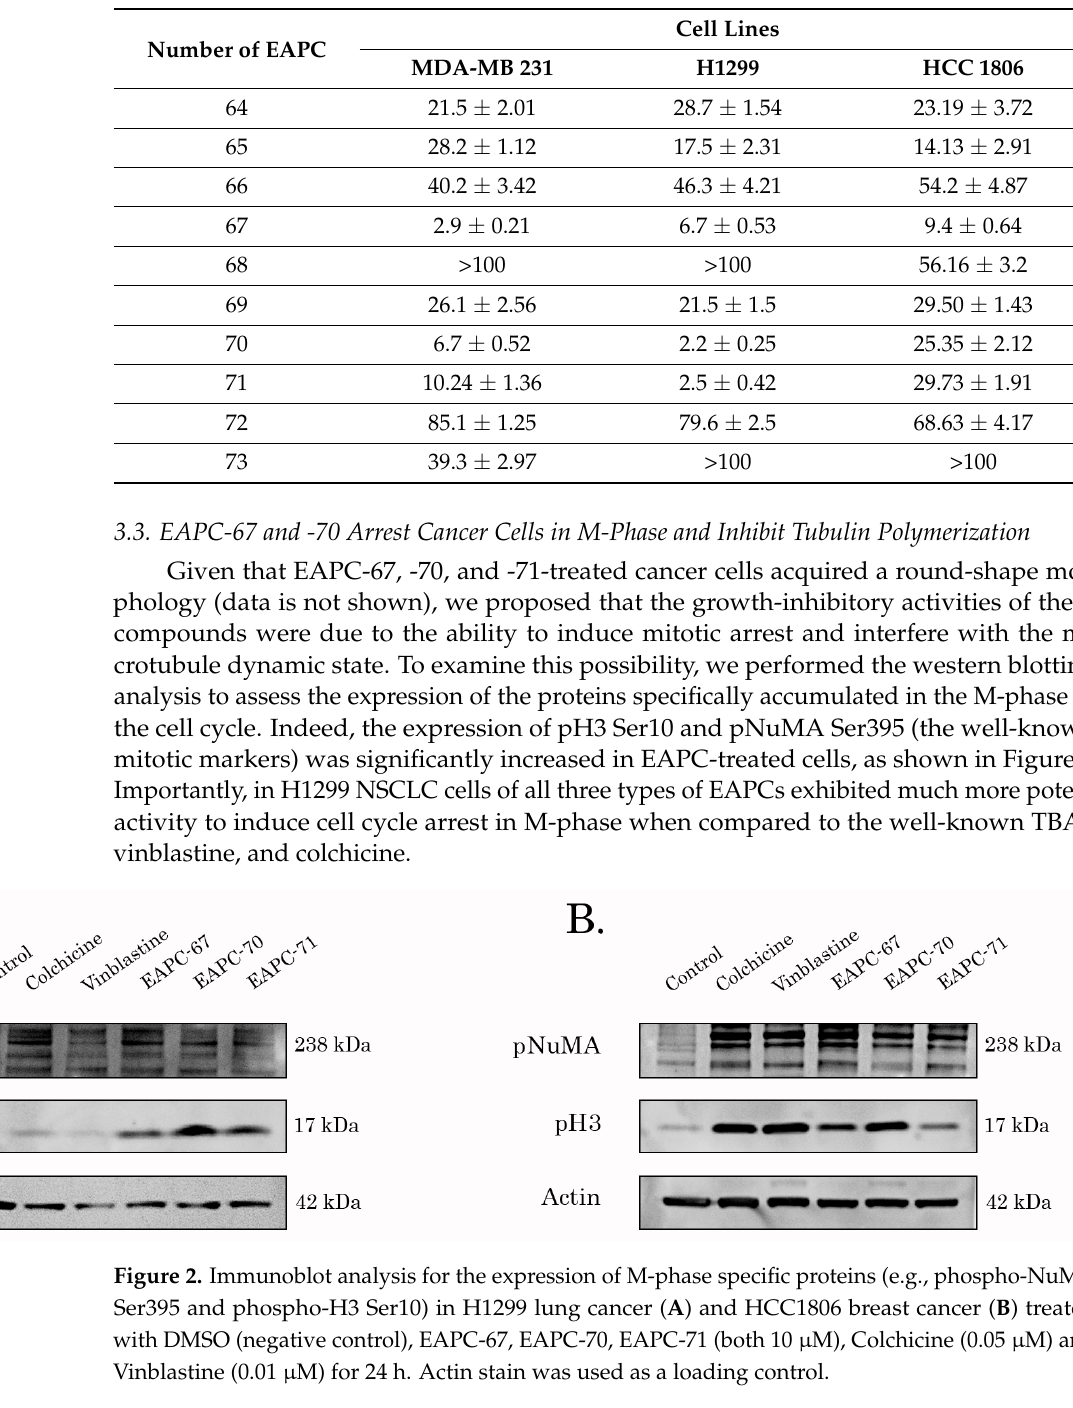
Table 1. IC 50 values (in the micromolar range) for EAPCs in HCC1806, MDA-MB-231 triple-nega- tive breast cancer, and H1299 non-small cell lung cancer cell lines.